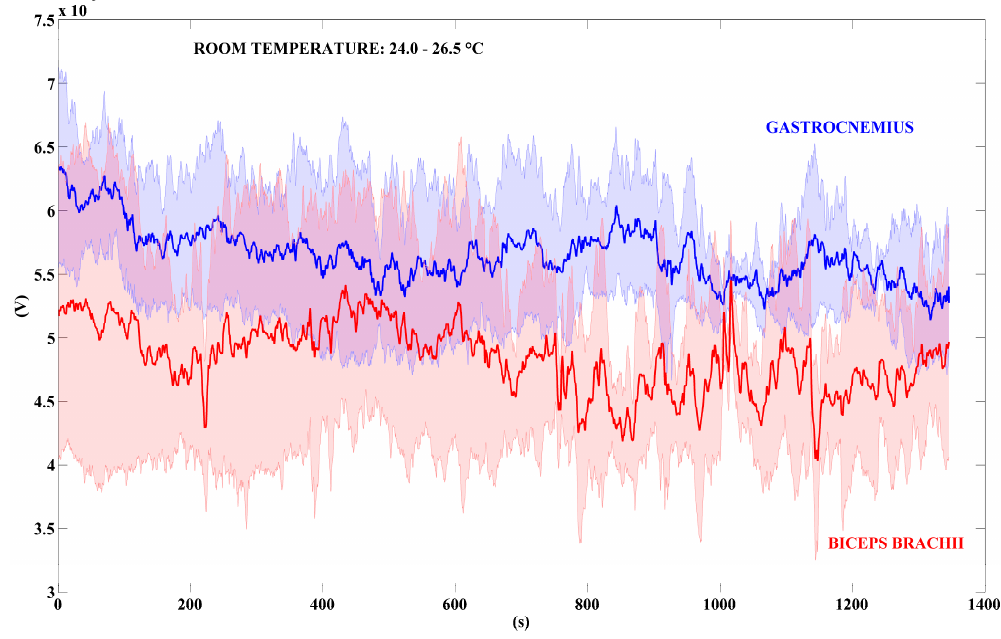
Figure 9. Voltage output signals generated by the TEG. The bold red line represents the mean value of the TEG placed on the biceps brachii; the bold blue line refers to the gastrocnemius. The blue and red areas around the bold lines represent the standard deviations (n = 5). Time-interval: 1350 s.